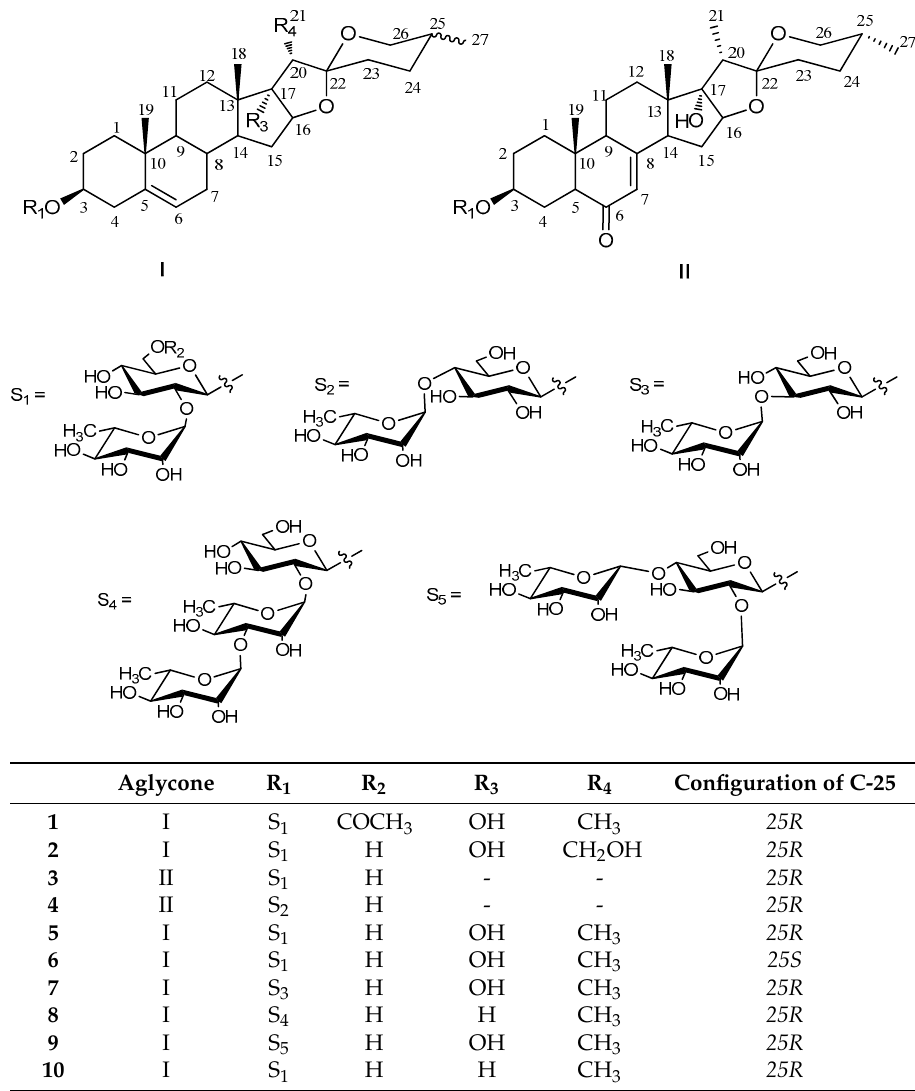
Figure 1. Structures of Compounds 1–10 from Paris vietnamensis